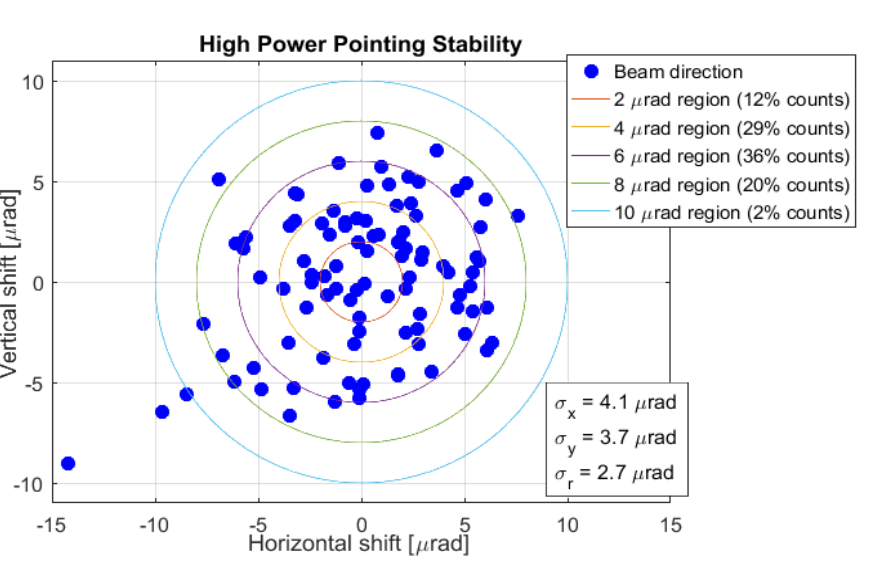
Figure 11. Pointing stability in µ rad measured at the ELIMAIA BDS using L3 at low power (upper plot) and at full power (lower plot) during a series of 100 consecutive shots at about 1Hz.